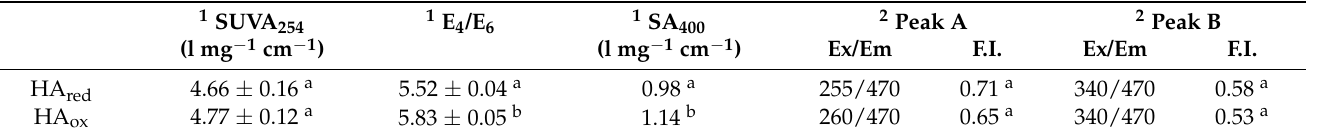
Figure 4. Oxidative charge responses to spikes of increasing HA ox ( a ) and HA red ( b ) masses, added in the electrochemical cell containing ABTS 2 − /ABTS ●− in equilibrium to the working electrode (E h = 0.606 V, pH 7). Insets: Linear correlation between the moles of electrons ( n e − ) transferred to the WE versus the mass of HA ox ( a ) and HA red ( b ) after 60 min from addition. The slopes of the linear regression models correspond to the EDC values. Table 2. Spectroscopic parameters of humic acids extracted after aerobic (HA ox ) and anaerobic (HA red ) incubations. Different letters (a, b) refer to significant differences (HSD test, p < 0.05). All data are expressed on a dry weight